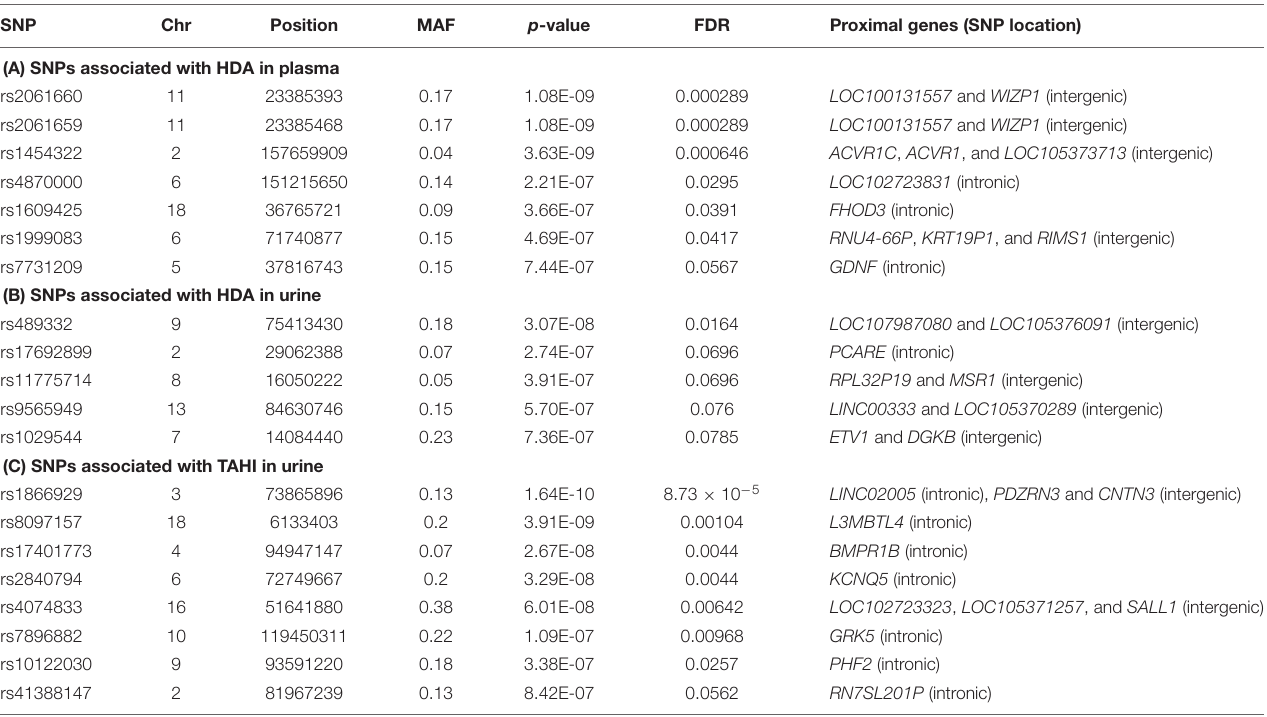
TABLE 1 | Genes proximal to the 20 single-nucleotide polymorphisms (SNPs) [minor allele frequency (MAF) > 0.10] significantly associated with differences in isocyanate plasma and urine biomarker levels when adjusted for inhalation and skin exposure covariates. SNP Chr Position MAF p